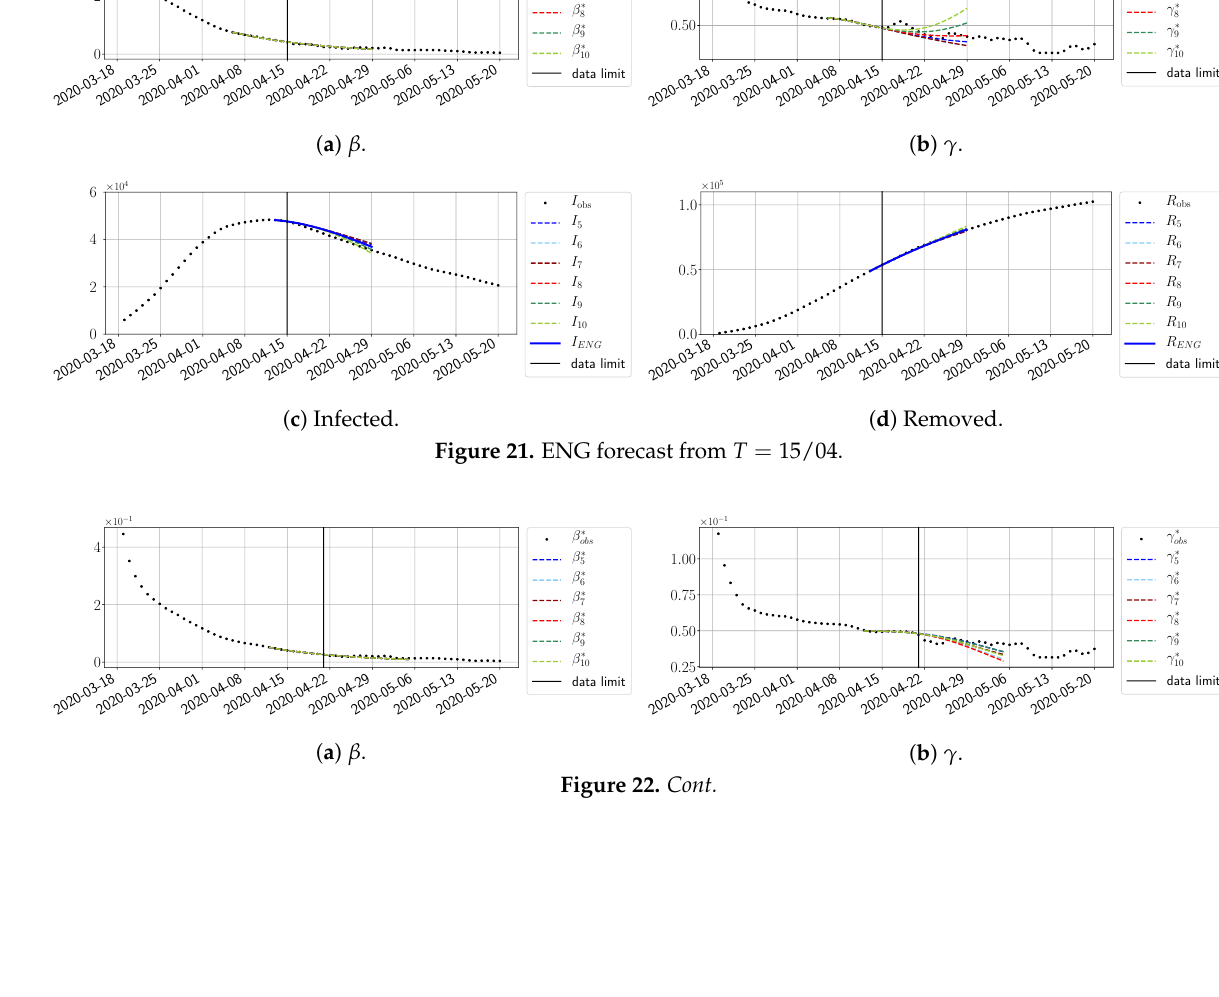
Figure 20. ENG forecast from T = 11/04.